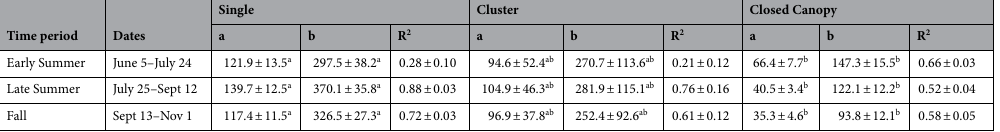
Table 2. Average parameters and R 2 of daily sum of sap flux density ( J S ) versus daily average vapor pressure deficit (VPD) relationships of the form y = a * ln(VPD) + b. Values are mean ± SE. Unique letters indicate cross site differences within each time period based on post hoc analysis.